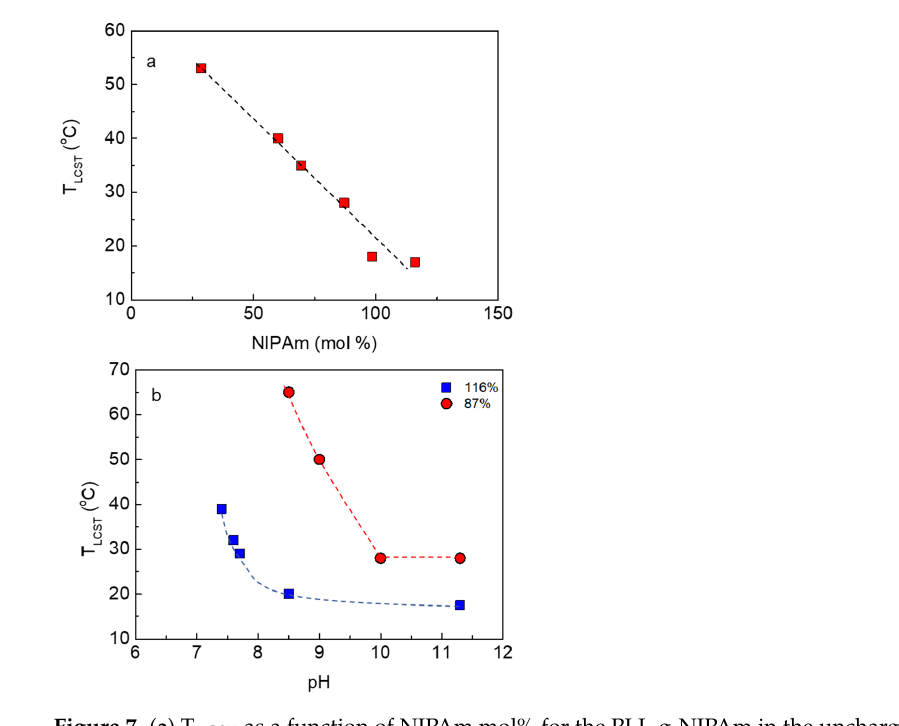
Figure 7. ( a ) T LCST as a function of NIPAm mol% for the PLL-g-NIPAm in the uncharged state of the free amines (pH > 11). The line represents the linear fitting of the data and LCST as a function of pH ( b ) for various PLL-g-NIPAm of different mol% NIPAm (as indicated). The lines represent guide for the eyes. More importantly, for the partially grafted samples, T LCST is strongly pH-dependent.